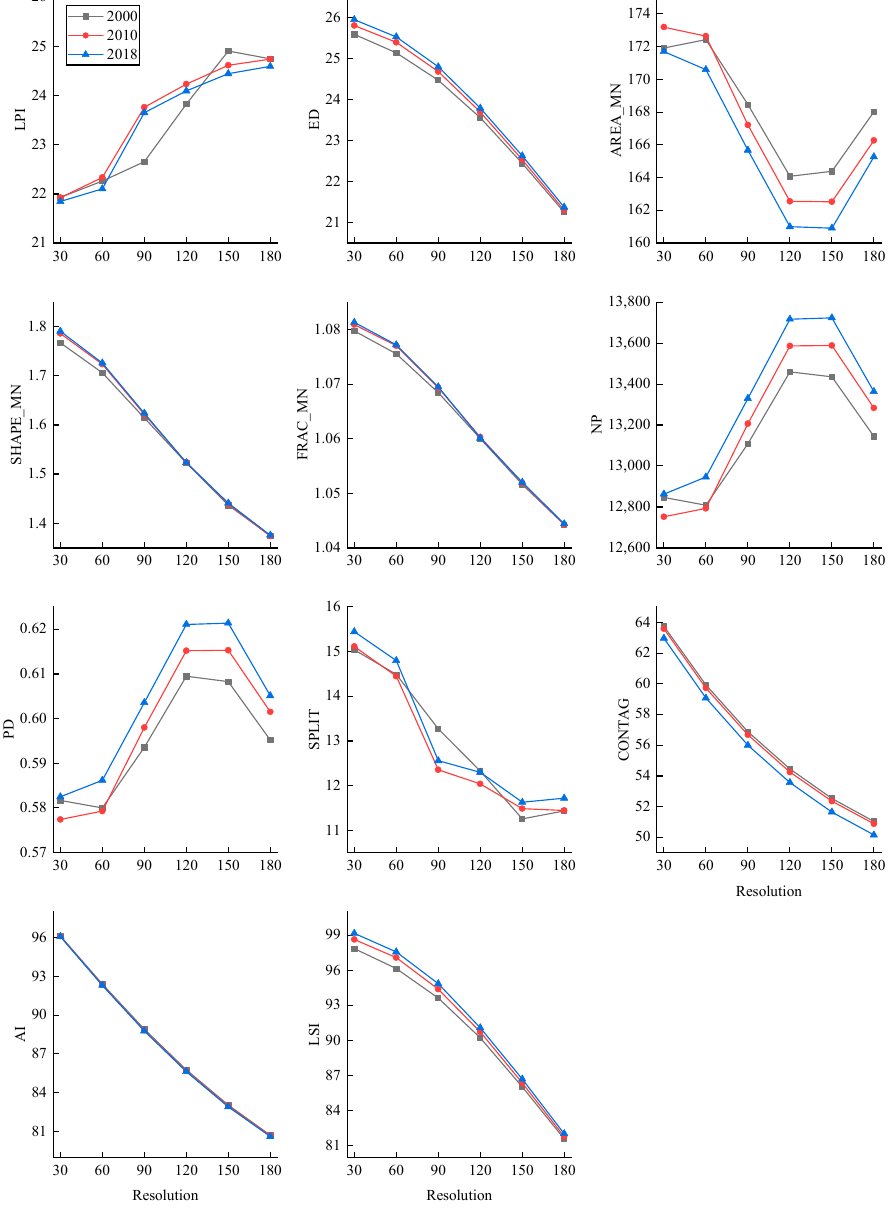
Figure 5. Granularity effect of the landscape pattern index. Table 2. Fitting model parameters of the ecological risk semi-variogram under different